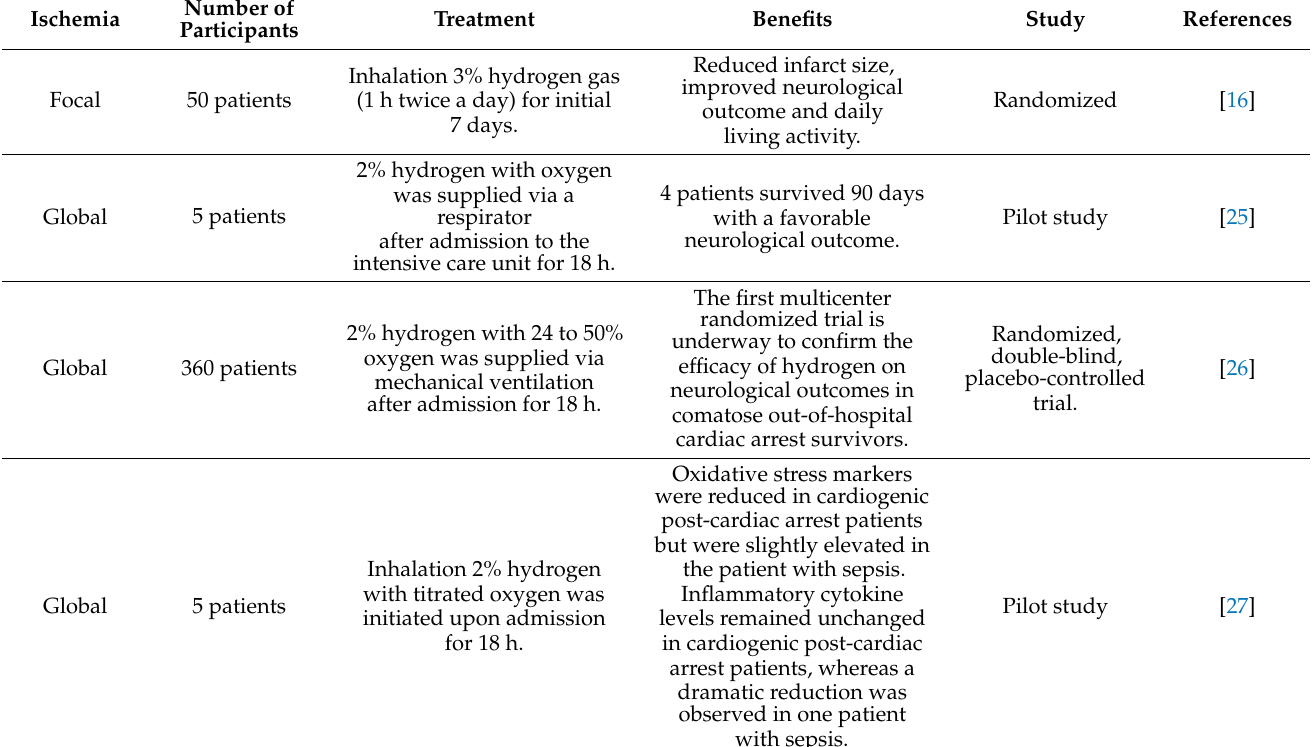
Table 1. Neuroprotective effects of molecular hydrogen in clinical post-ischemic brain